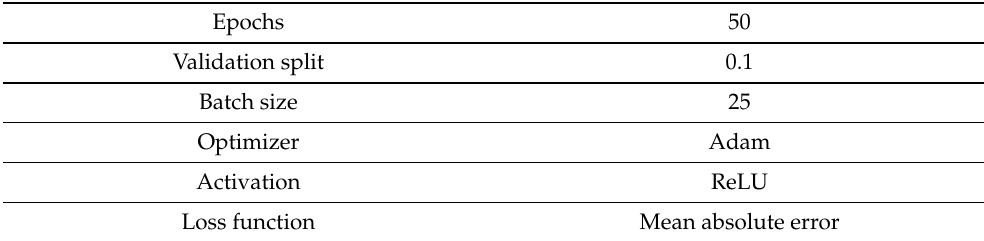
Table 5. Model parameters for battery fault analyses in